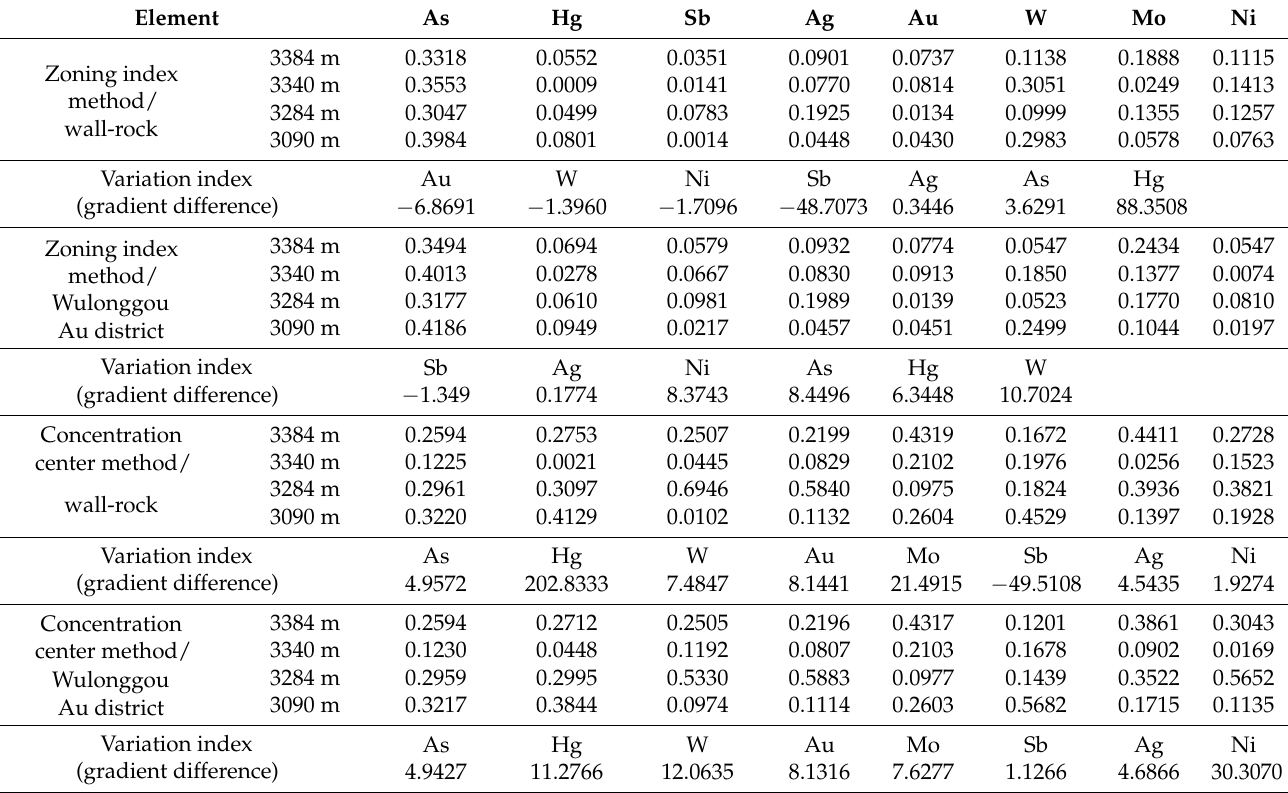
Table 2. Axial zoning results for the Yanjingou ore body.